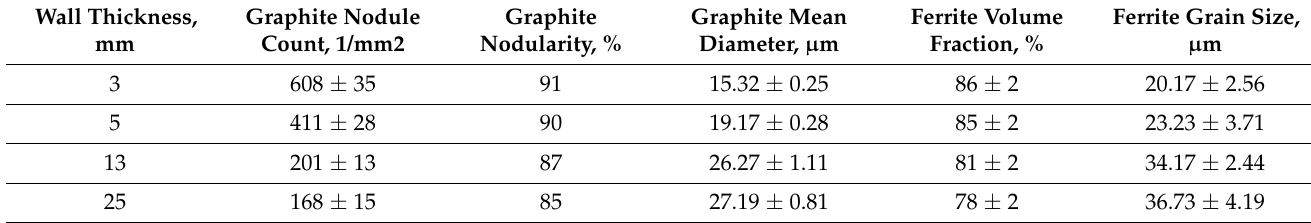
Table 3. Image analysis results for samples with four wall thicknesses.